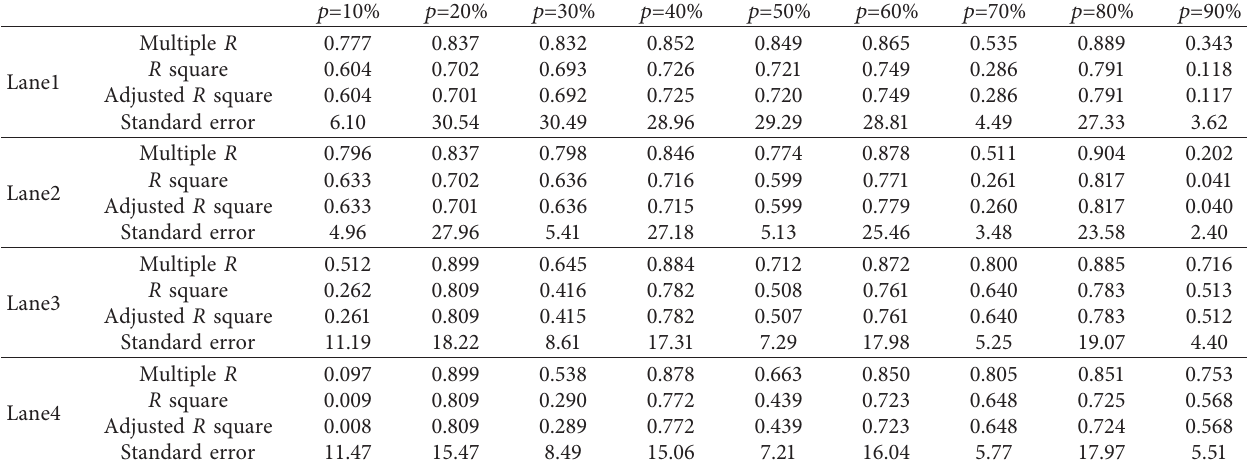
Table 6: The degree of the fit table of the relationship between the speed and the lane change rate under different penetration rates of autonomous vehicles in each